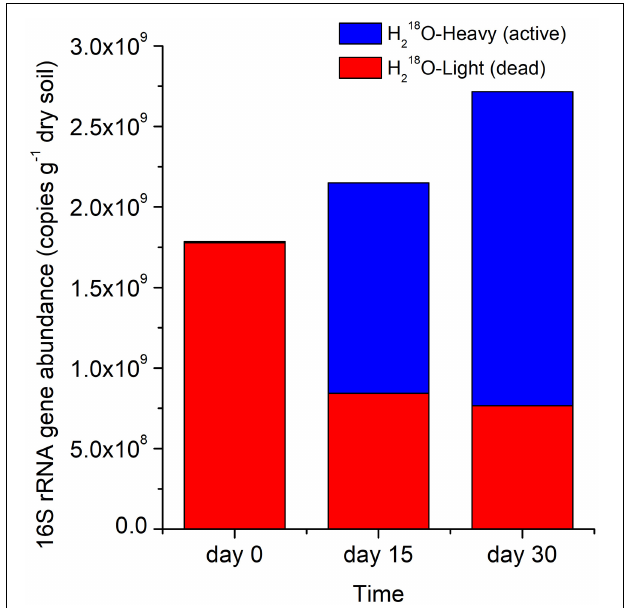
FIGURE 3 | Stacked 16S rRNA gene abundance in H 218 O heavy or light fraction at different times. Light and heavy fractions in H 218 O treatments represented DNA of dead and active bacteria and archaea,